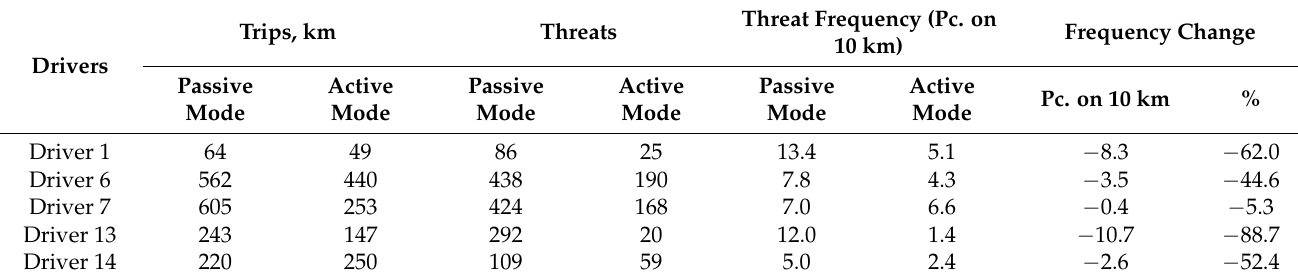
Table 2. In-the-wild